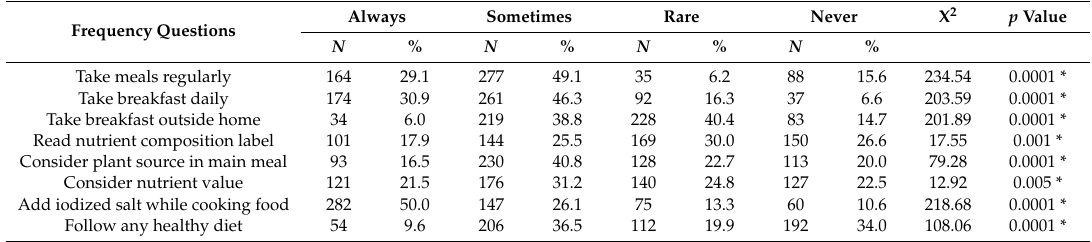
Table 3. Frequency of dietary practices among students ( n =